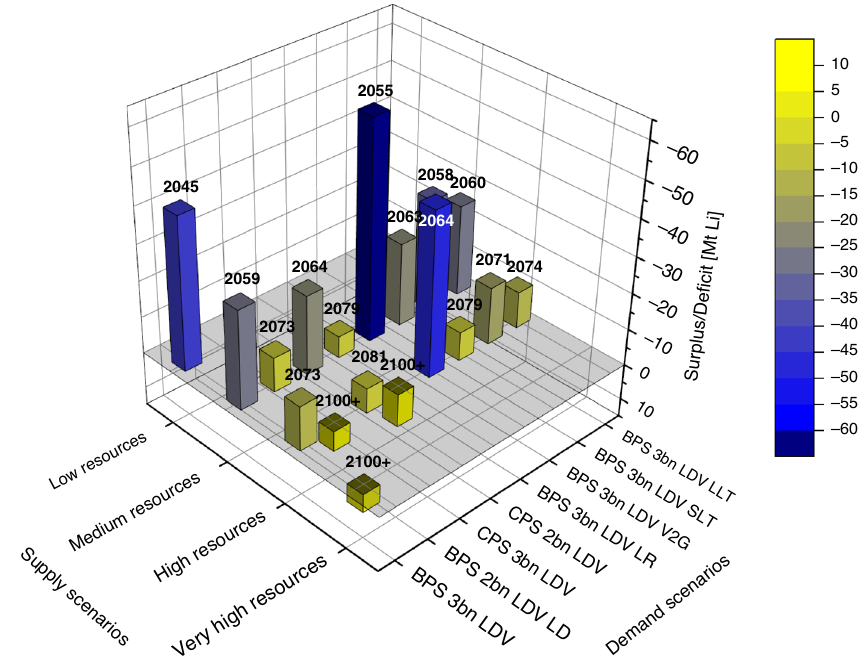
Fig. 4 Availability of lithium in the year 2100. The comparison of resources and demand represented by cumulative drain plus Li in stock is shown in 18 scenarios of surplus and de fi cit, respectively. Above each column, the year of depletion is indicated by case.